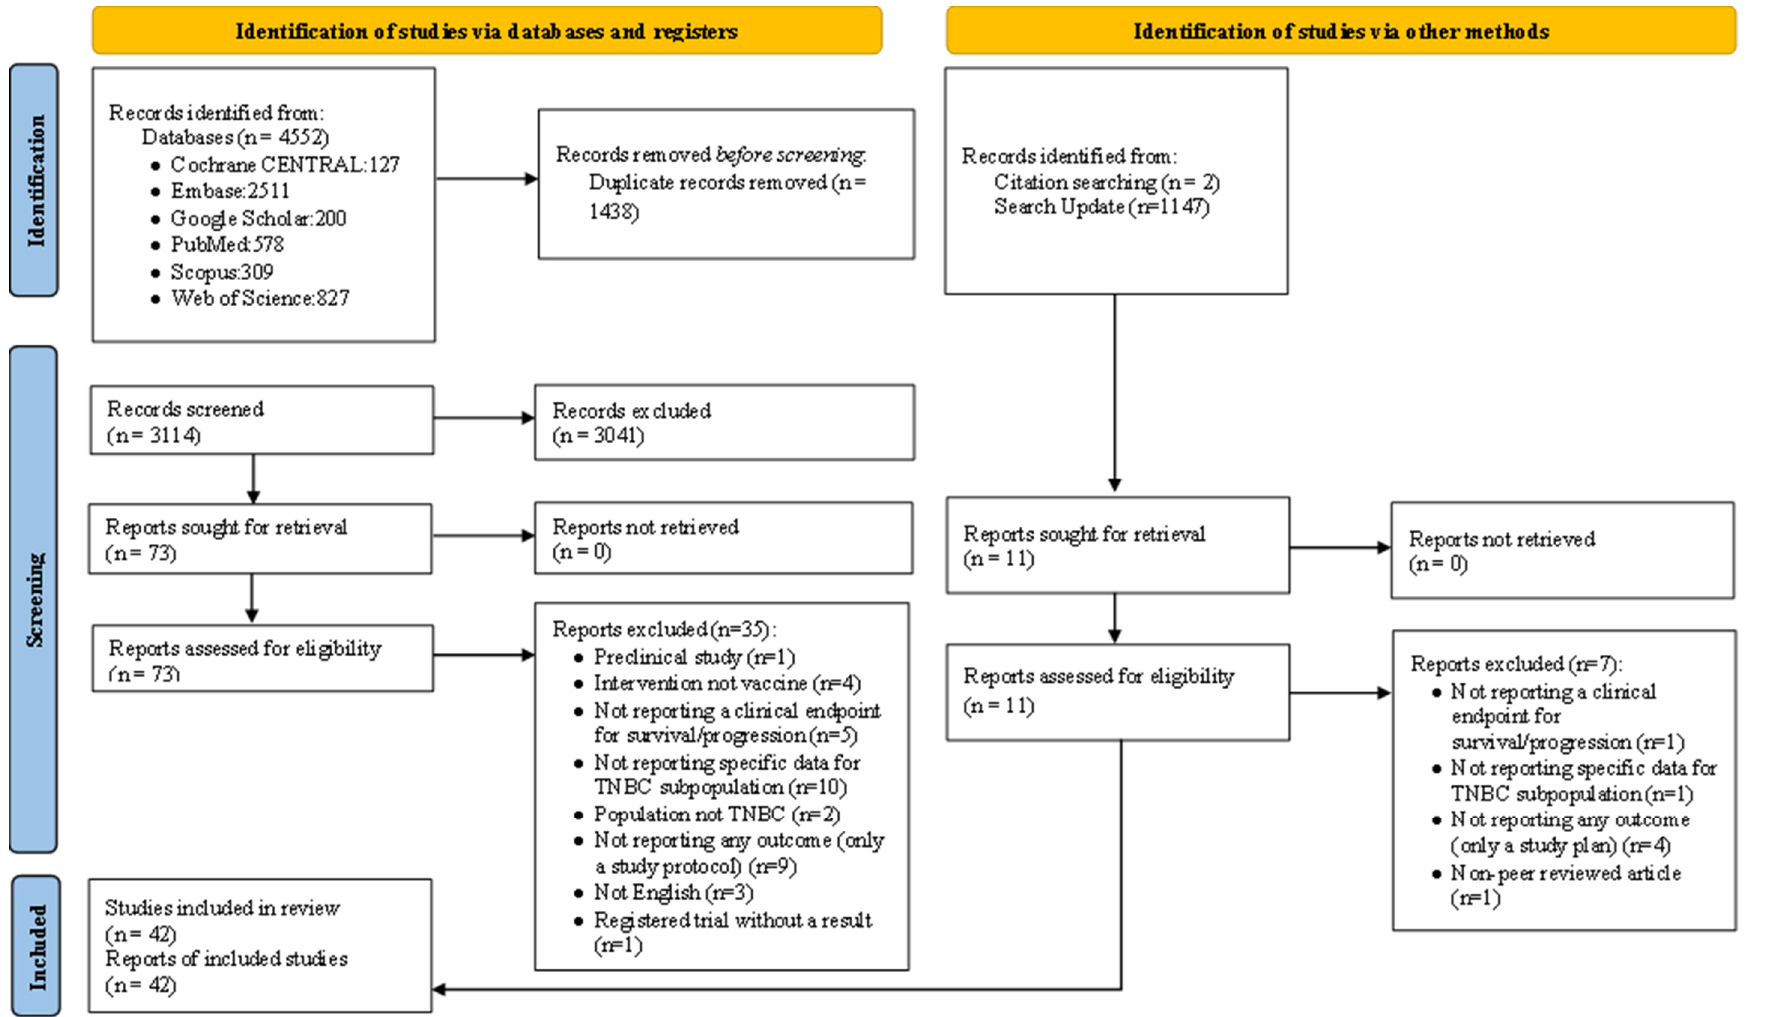
Figure 1. PRISMA flowchart of the study process.